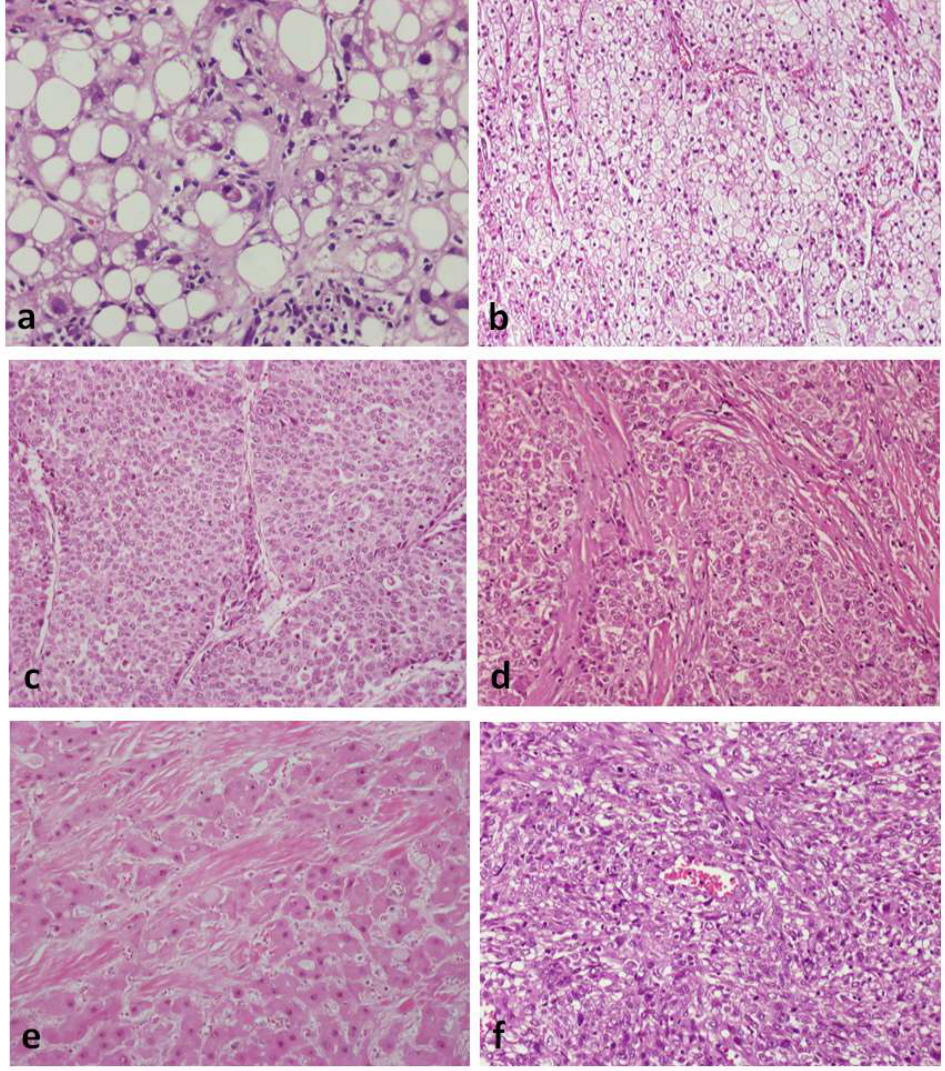
Figure 5. Examples of HCC subtypes: ( a ) steatohepatitic; ( b ) clear cell; ( c ) macrotrabecular; ( d ) scir- rhous; ( e ) fibrolamellar; ( f ) sarcomatoid.